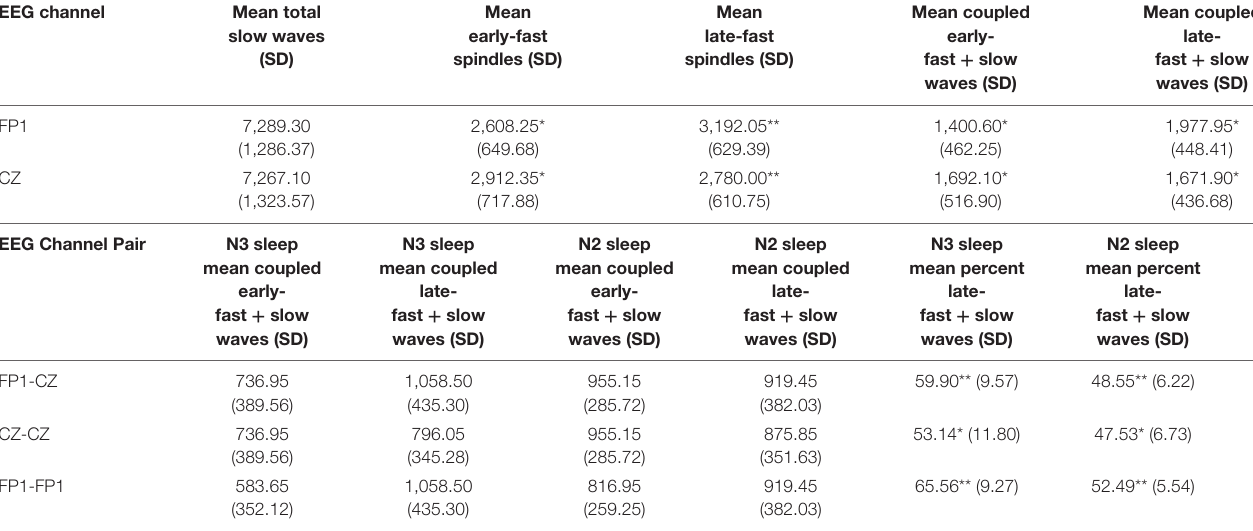
SD, standard deviation. For statistical comparison between FP1 and CZ: *denotes P < 0.001, and **P <